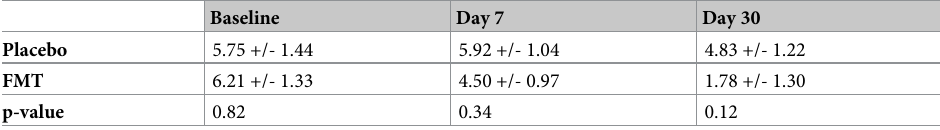
Table 3. The CCECAI between treatment groups at baseline, day 7 and day